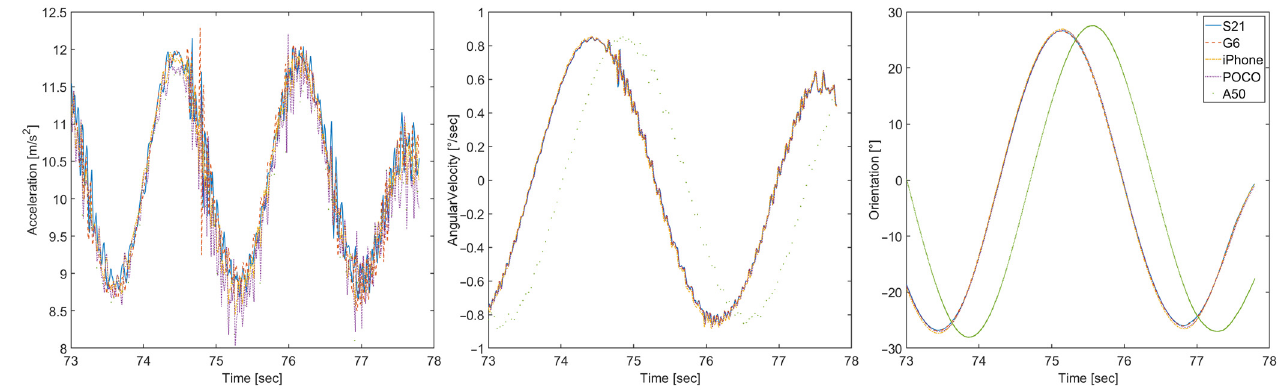
Figure 17. Acceleration on the z -axis ( left ), angular velocity on the x -axis ( center ), and orientation on the z -axis ( right ) obtained for five smartphones under